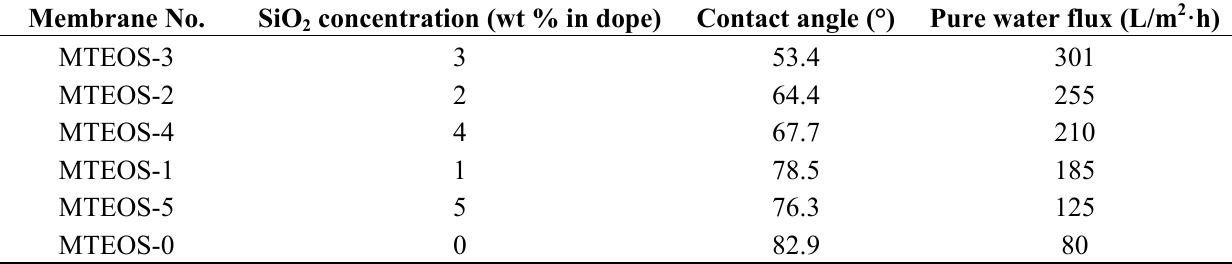
Table 2. Properties of PVDF/SiO hollow fibre membranes (arranged according to the 2 intensity of the β -phase peak; largest on top). Reproduced with permission from [25]. Copyright 2009